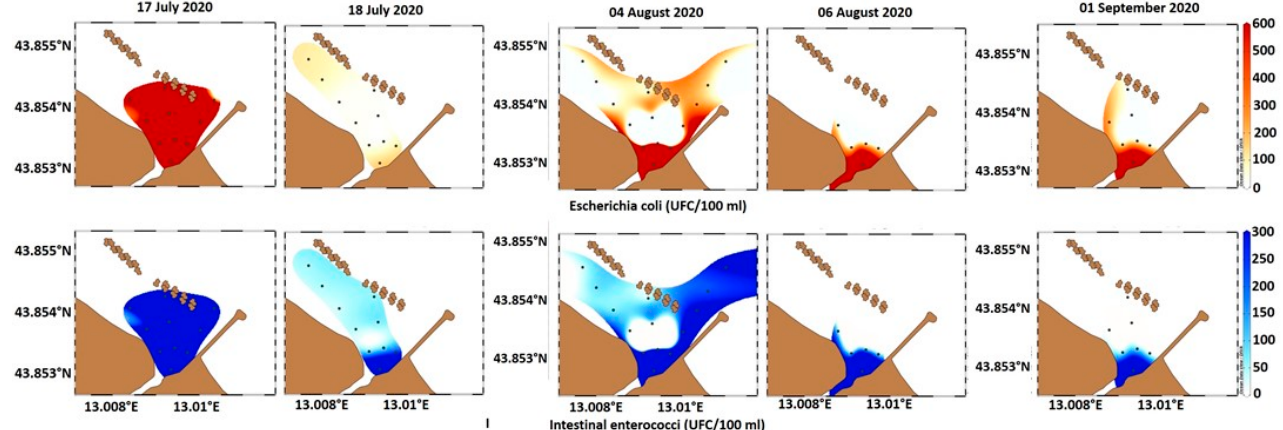
Figure 6. Ocean data view [15] maps showing the spatial distributions of microbial faecal contamination in seawater from sampling stations to offshore along the three transects in front of the Arzilla mouth during the 2020 rainy events (July, August and September). The graphs show relative abundance in colony-forming units of Escherichia coli (in red) and intestinal enterococci (in blue).